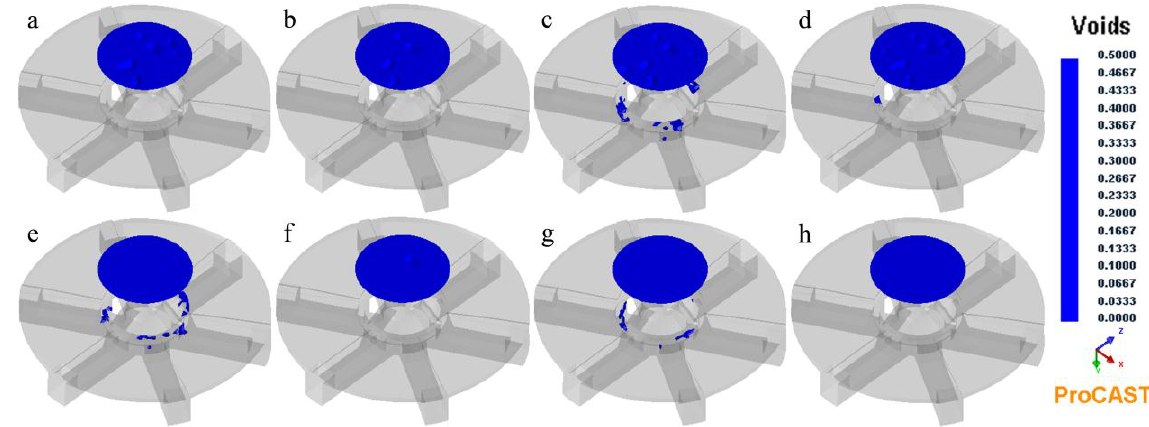
Figure 3. Predicted voids of test castings, ( a – h ), the same as the Figure